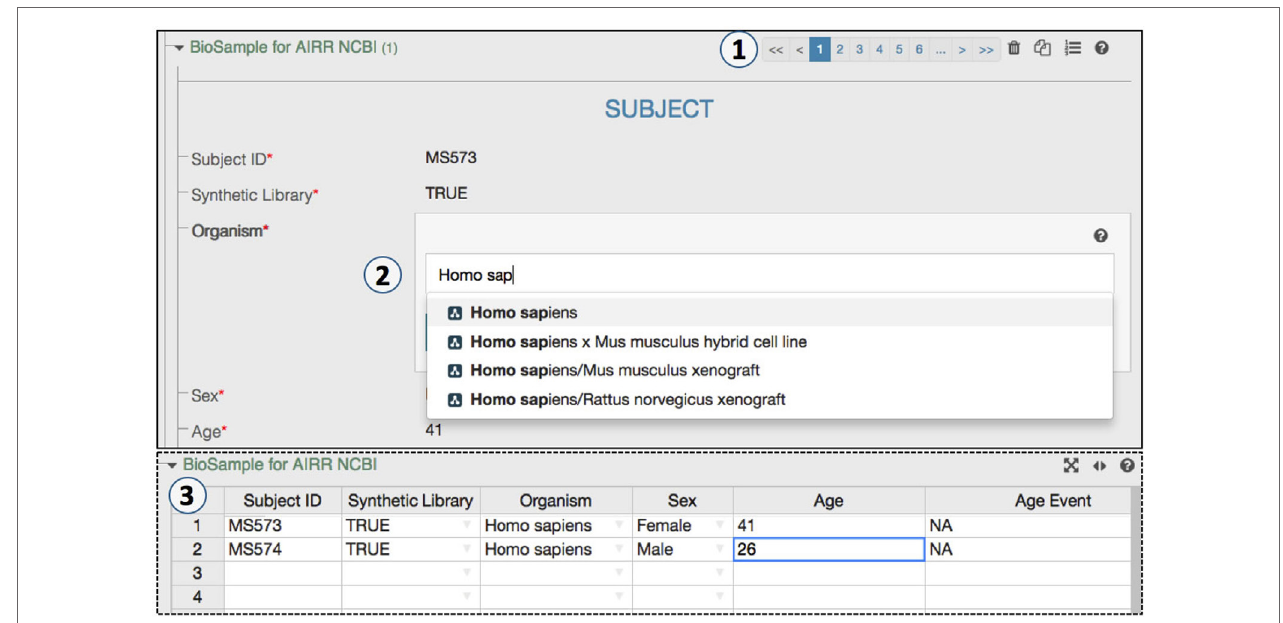
FIgURe 3 | An ontology-controlled adaptive immune receptor repertoire study metadata editing process. (1) CEDAR’s Metadata Editor presents this web form based on the MiAIRR template produced by the Template Designer. The paging option allows a data submitter to add or delete BioSample and sequence read archive (SRA) records. (2) Some of BioSample and the SRA metadata are controlled through ontologies, which allow for auto-completion during data entry. (3) The toggle spreadsheet option allows data submitters to edit metadata using a traditional spreadsheet